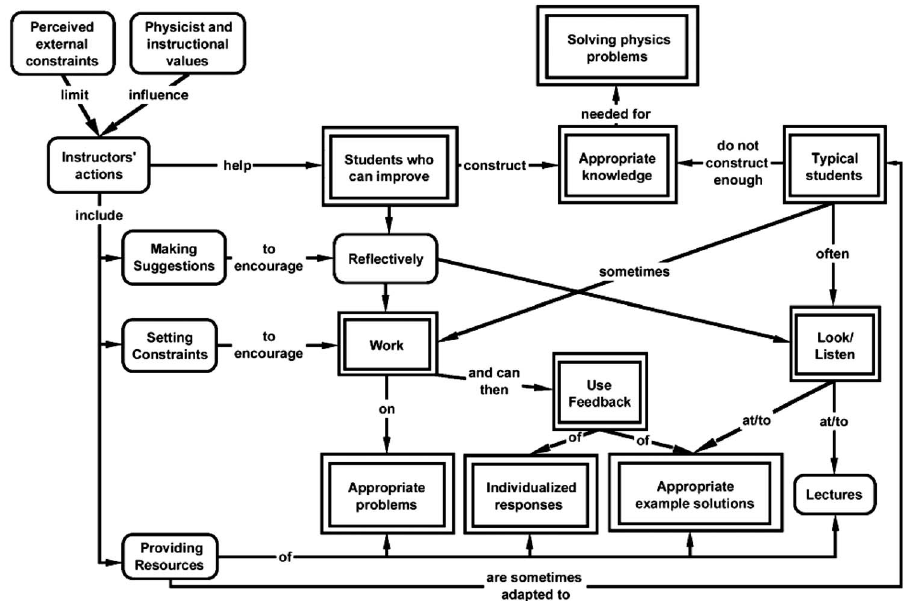
FIG. 5. Final main map result- ing from the analysis process. Cat- egories in double boxes have